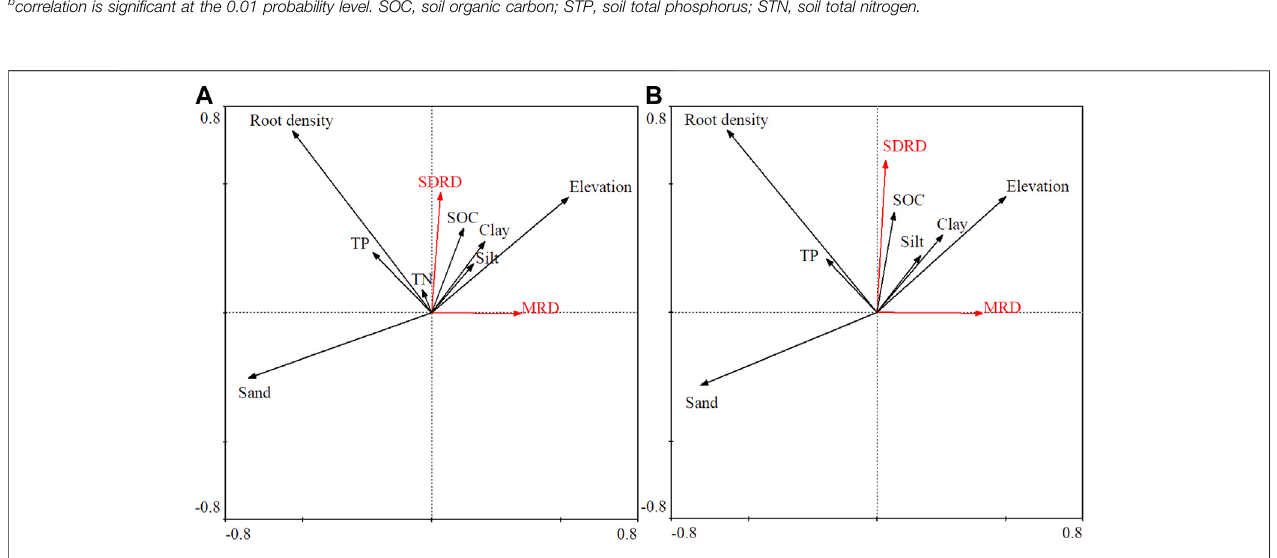
Frontiers in Earth Science |